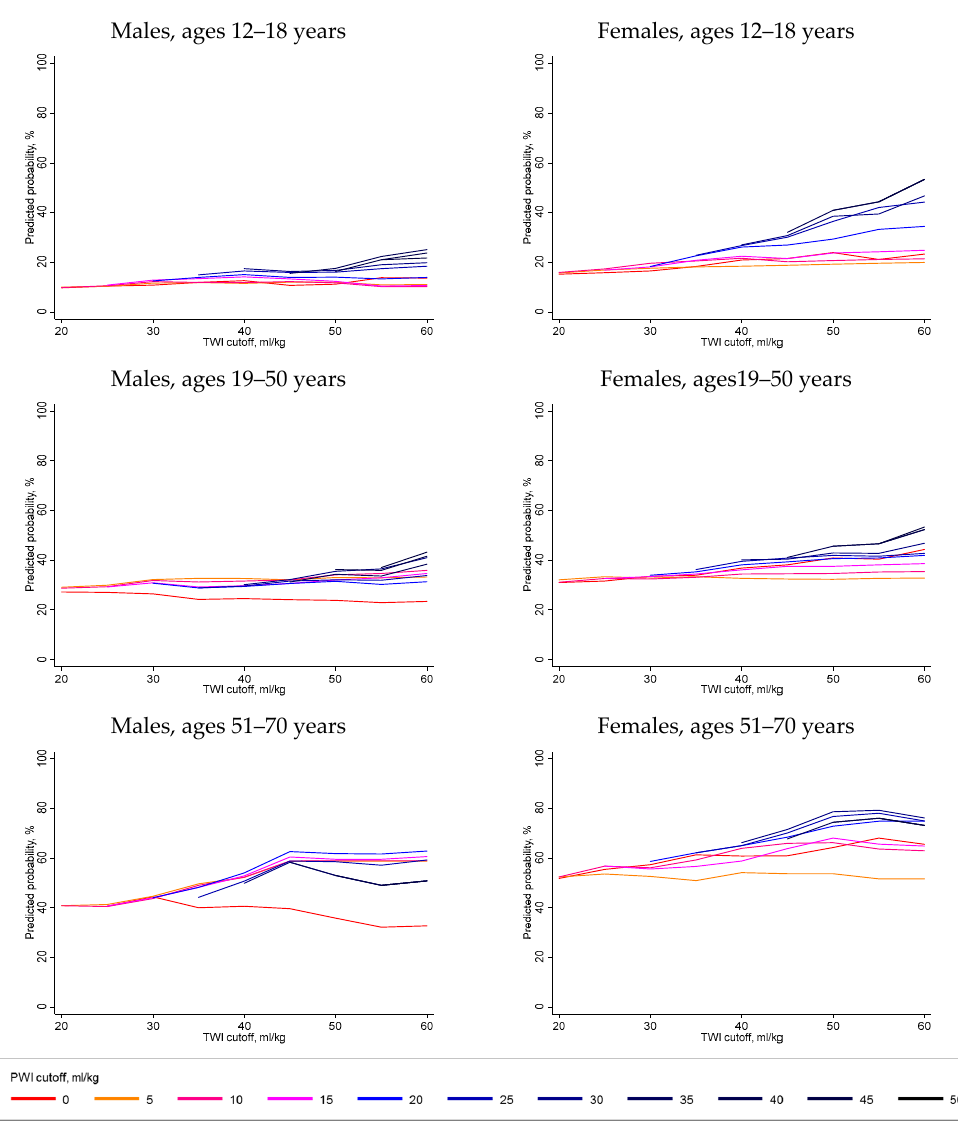
Figure 3. Predicted probability of meeting hydration criteria associated with TWI at or above cutoffs ranging from 20–60 mL/kg or PWI at or above cutoffs ranging from 0–50 mL/kg for the US population and sub-group without selected chronic disease risk factors by sex and age. Participants were classified as hydrated if they had a serum sodium of 135–144 mmol/L, a urine volume ≥ 50 mL, and a urine osmolality < 500 mmol/kg. The probability of meeting the hydration criteria was predicted from weighted, age- and sex-specific logistic regression models that adjusted for age in years, body weight, solute load, race–ethnicity, level of physical activity, cigarette smoking, any prescription medication used in the past month, and season of the MEC visit. The probabilities were predicted holding each covariate at its mean for each sex and age group. See the interactive Tableau dashboard for further detail (Supplementary Figure